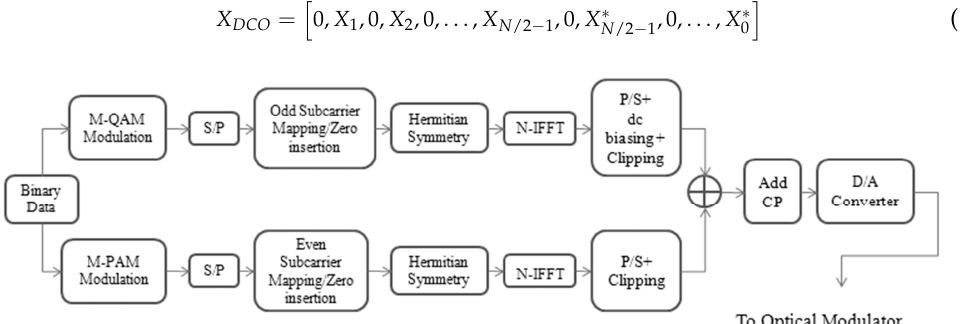
Figure 1. DC-biased pulse amplitude modulated orthogonal frequency division multiplexing (DPO-OFDM) transmission side where dc-biased optical OFDM (DCO-OFDM) and pulse amplitude modulated discrete multitone (PAM-DMT) electrical signals are formed and then combined and converted to the optical domain. Note that QAM stands for quadrature amplitude modulation; while IFFT, S/P, P/S, CP and D/A stand for inverse fast Fourier transform, serial-to-parallel, parallel-to-serial, cyclic prefix, and digital-to-analog, respectively.